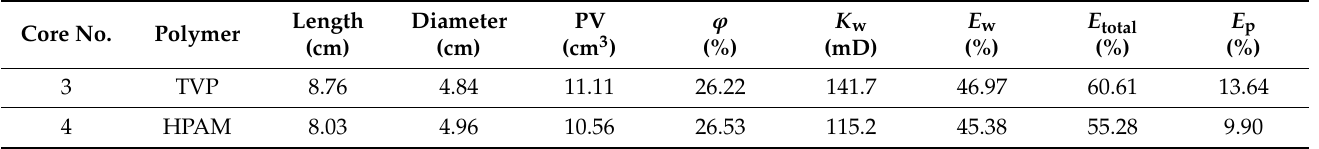
Table 2. The core flooding results of 0.1% TVP and HPAM solutions at 45 ◦ C. Core